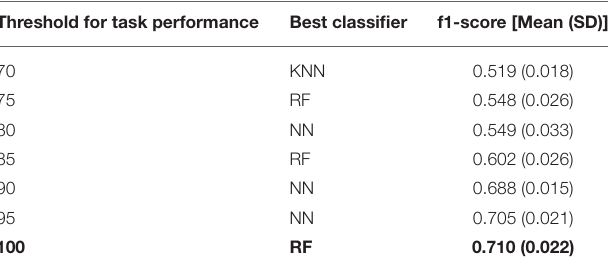
TABLE 5 | Best score achieved by the model to predict task difficulty at each threshold of task performance. Threshold for task performance